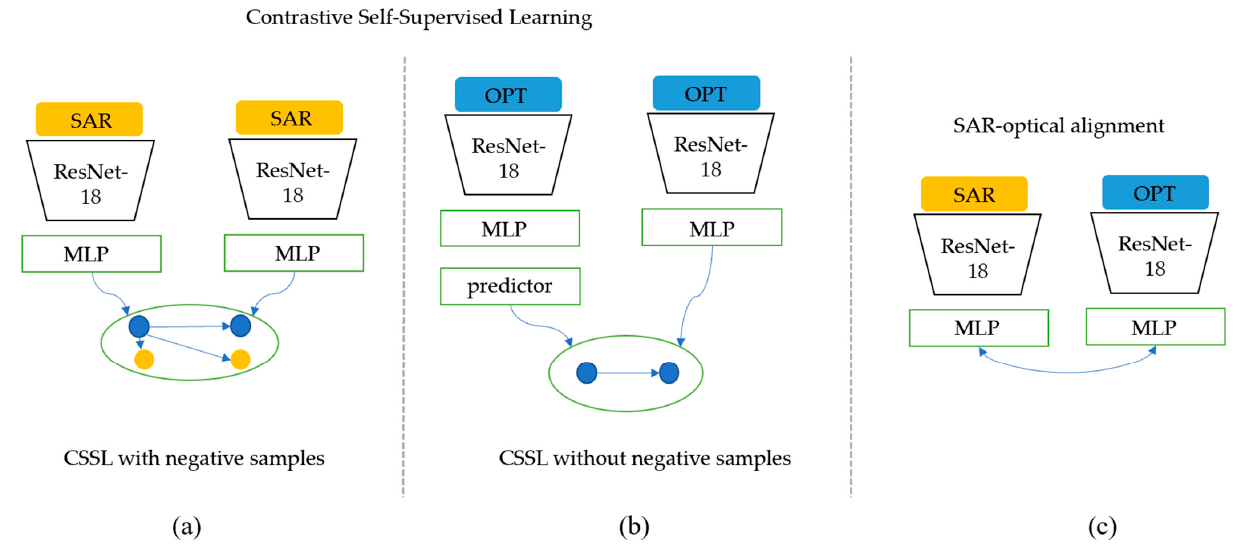
Figure 1. ( a ) Overview of model architectures of CSSL with negative samples; the blue balls represent the mapped vectors of positive samples, and the yellow ones represent the mapped vectors of negative samples. ( b ) Overview of model architectures of CSSL without negative samples; features from homologous data are mapped into space to predict each other. ( c ) Overview of SAR-optical alignment module.